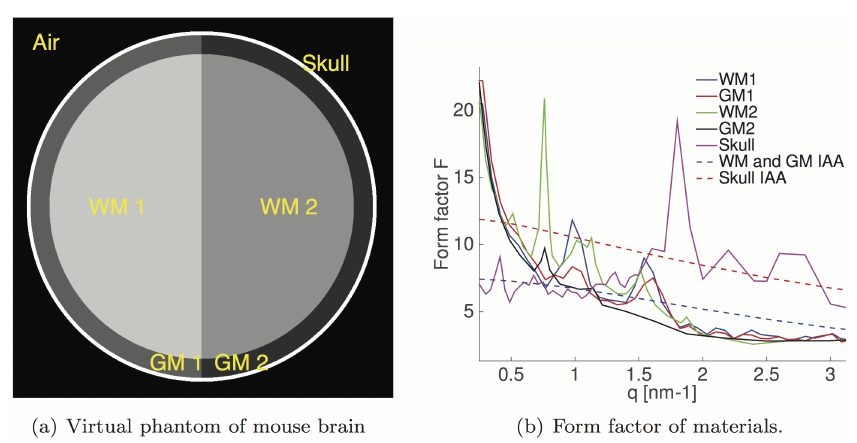
Fig 4. (a.) Simplifiedcylindricalmodel of a mouse head slice. (b.) Coherent scattering form factor for WM1, WM2, GM1, GM2 and skull materials. dotted line: form factors calculatedwith IAA. Solid line: form factors measuredin this